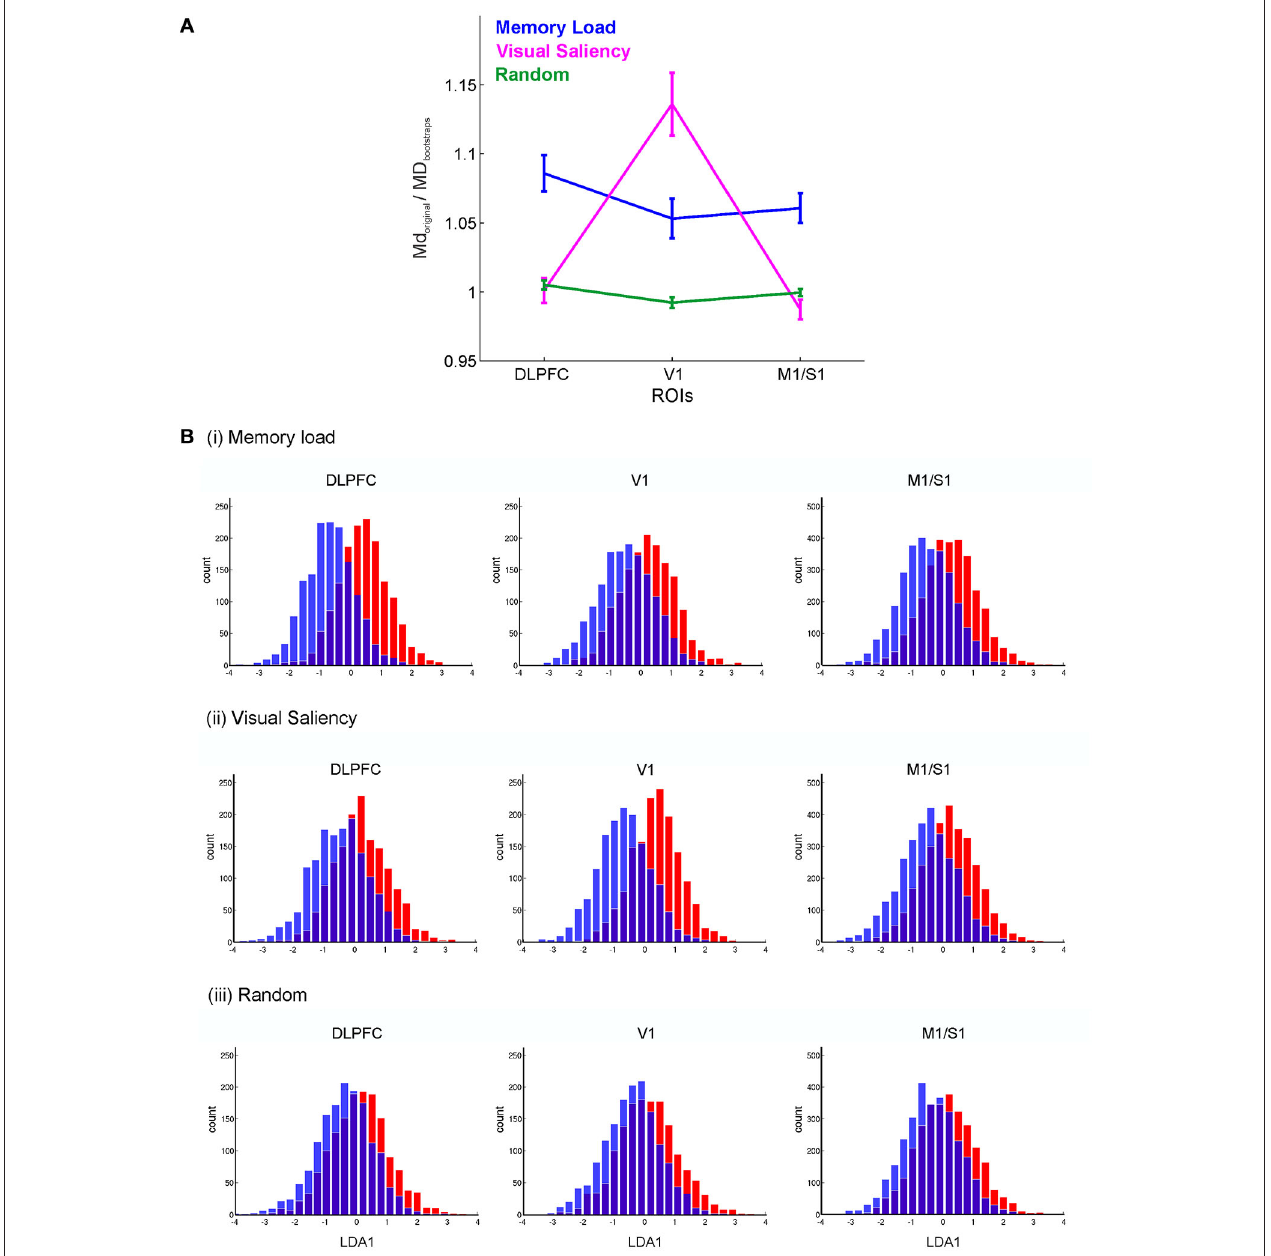
FIGURE 4 | Decoding of the choice process for different classification schemes. (A) Mahalanobis distances (MD) normalized by the corresponding block-permutation bootstraps between two sets of decision blocks grouped by high/low memory load, high/low visual saliency , and randomly , for the DLPFC, V1 and combined motor and somatosensory (M1/S1) regions. Error bars = SEM across participants. (B) Distribution of choice time points projected onto the most discriminating direction obtained by Fisher’s LDA. These results show the prominent role of the DLPFC in working memory, and that of V1 in processing visual saliency. Histograms represent z -scored projections onto the first Fisher’s LDA direction (LDA1) pooled across